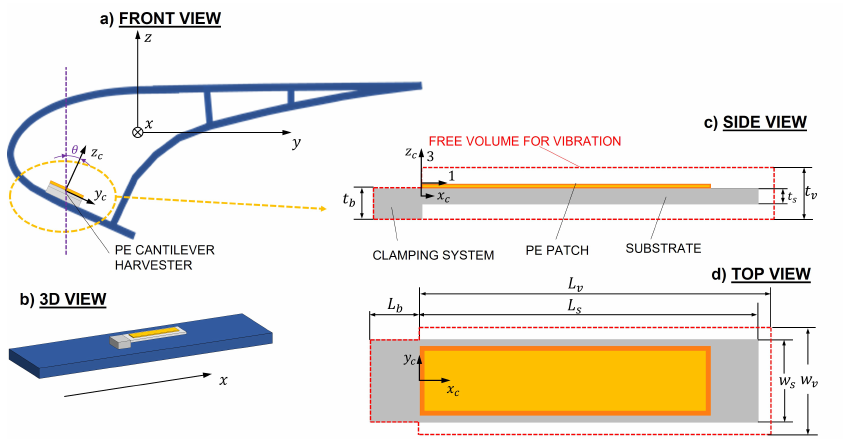
Figure 14. Example of PE cantilever harvester: ( a ) arrangement of the cantilever harvester; ( b ) the 3D view; ( c ) side view of the cantilever harvester and required free volume for vibration; ( d ) top view of cantilever